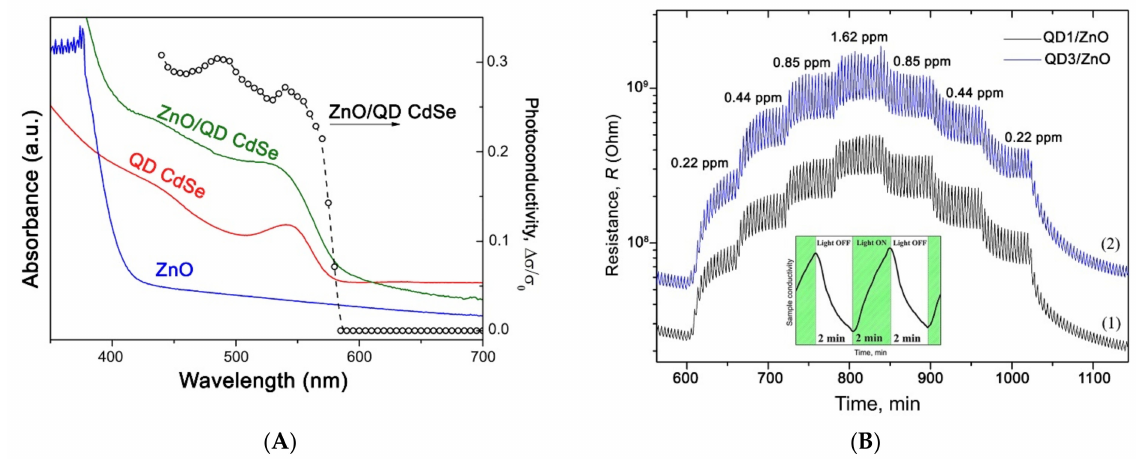
Figure 9. ( A ) Absorbance spectra of ZnO, CdSe QDs, and ZnO/QD_CdSe nanocomposite; ( B ) Gas sensor measurements of ZnO/QD_CdSe nanocomposites to NO 2 under periodic green light illumination and room temperature. Reprinted from [161] with permission from Esevier,